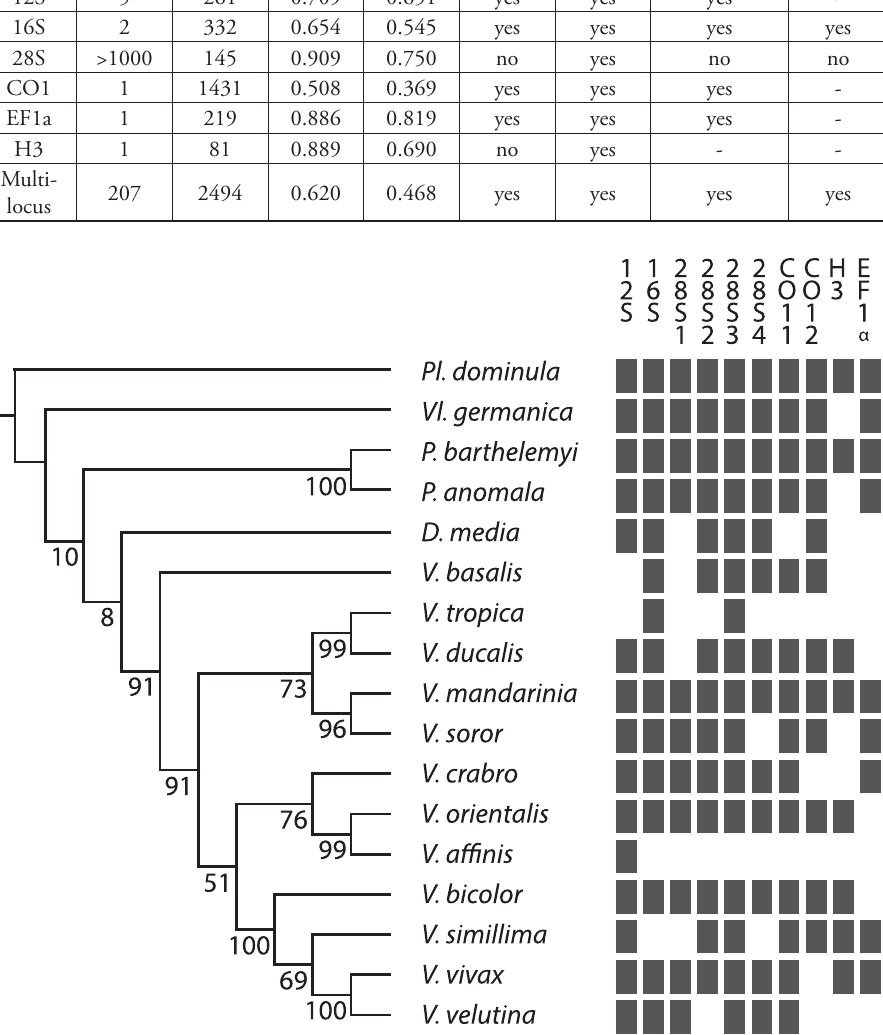
Figure 3. Support tree for the relationships among 13 Vespa species based on the six genes. Supports for nodes are given in GC-values. Grey rectangles show the molecular markers available for each